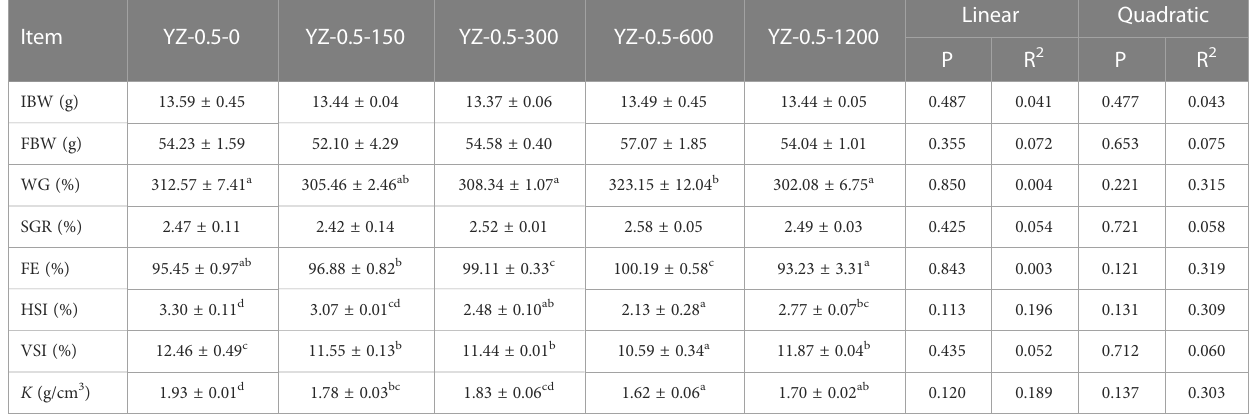
TABLE 6 Effects of dietary heteroglycan (YZ0.5-A) on growth performance, feed utilization, and morphometric parameters in hybrid